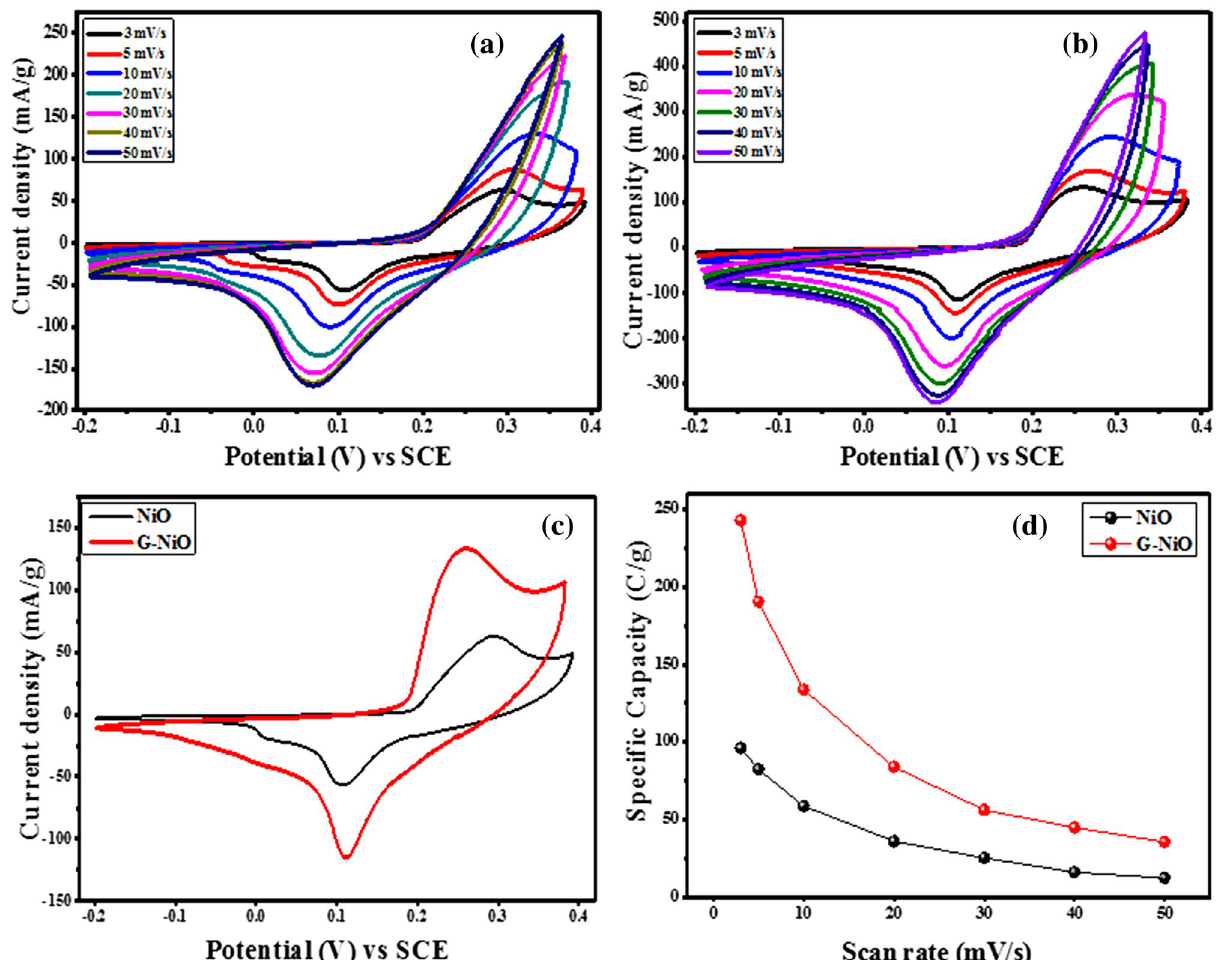
Figure 3. CV curves for ( a ) NiO electrode and ( b ) G-NiO electrode at different scan rates, ( c ) comparative CV curves for NiO and G-NiO at the same scan rate of 3 mV s −1 , and ( d ) corresponding graphs of specific capacity against scan rates for NiO and G-NiO